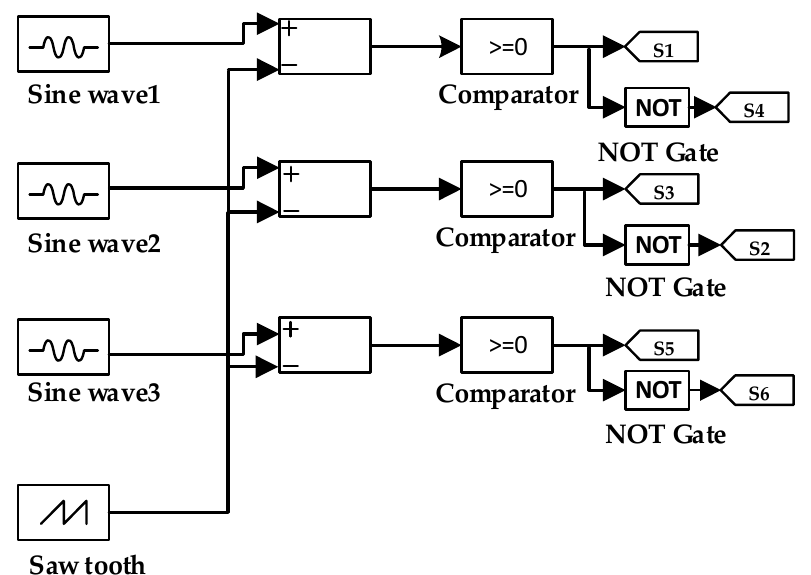
Figure 5. The gating signal generation for 3-phase inverter. In this method, three reference sinusoidal waveforms are separately compared with a common sawtooth carrier waveform as in Figure 6. Each comparison results in the switching pulse of the corresponding switch. Since one leg contains two complementary switches, control signals for both the switches in one leg will be opposite in nature, which are produced by using the NOT gate in the circuit.